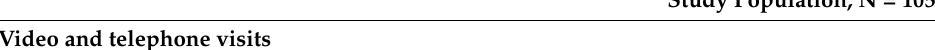
Table 2. Telehealth benefits, along with representative quotes by the caregivers. Video and telephone